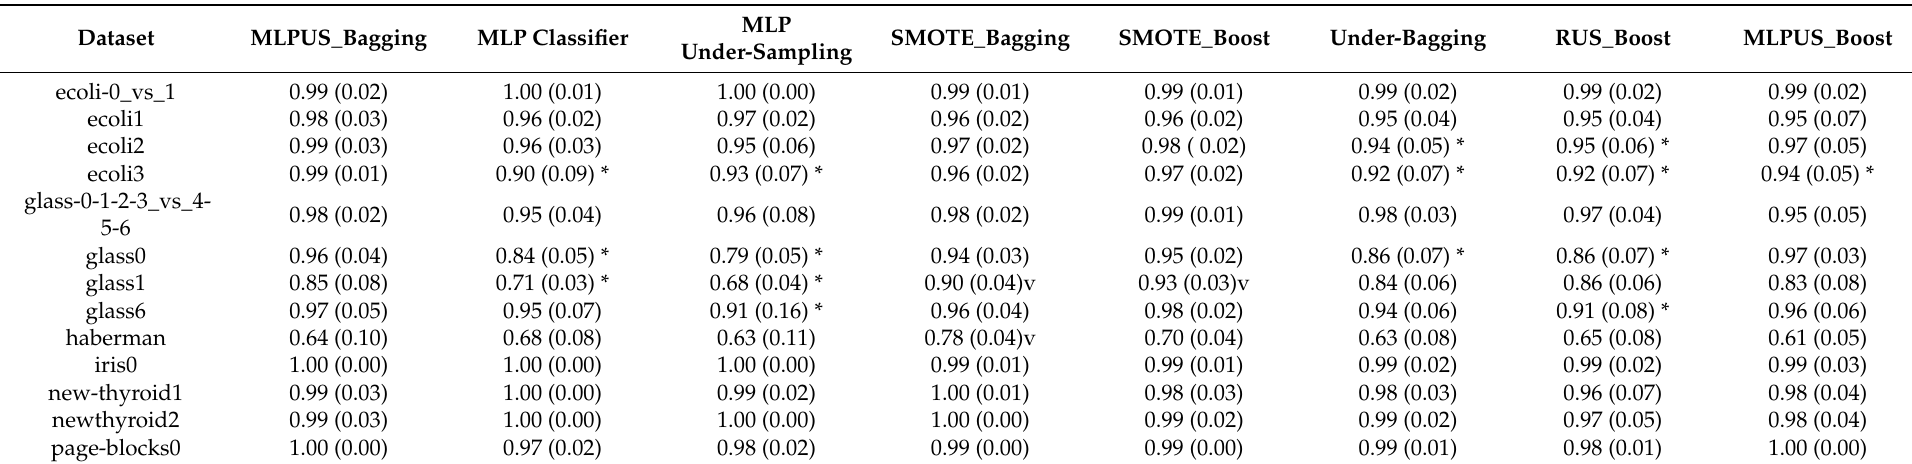
Table 7. Area under ROC results of all methods for all